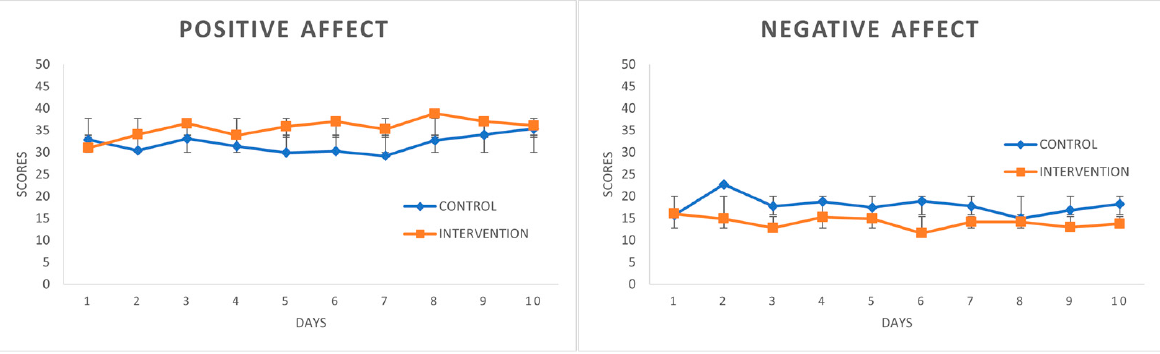
Figure 1 COPE Variables in Control Condition and Intervention Condition. Mean values (SD).